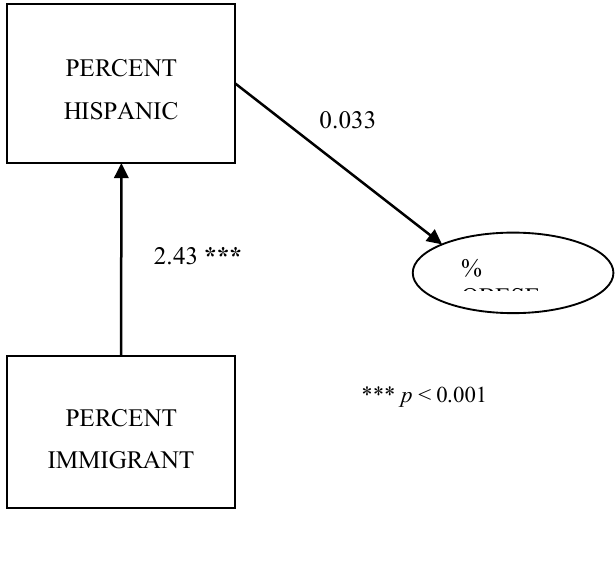
Figure 3. Path analysis for county level obesity, % Hispanic, and %